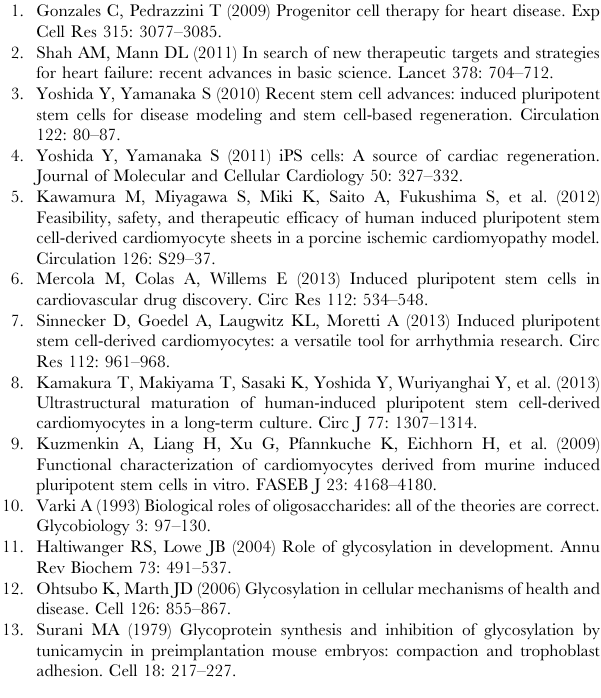
Table S2 Structures and relative quantities of neutral (Table S1, S2) PA-oligosaccharides derived from iPSC, iPSC-CM, and heart cells. (TIFF) Table S3 Structures and relative quantities of mono- sialyl (Table S3, S4) PA-oligosaccharides derived from iPSC, iPSC-CM, and heart cells. (TIFF) Table S4 Structures and relative quantities of mono- sialyl (Table S3, S4) PA-oligosaccharides derived from iPSC, iPSC-CM, and heart cells. (TIFF) Table S5 Structures and relative quantities of disialyl PA-oligosaccharides derived from iPSC, iPSC-CM, and heart cells.